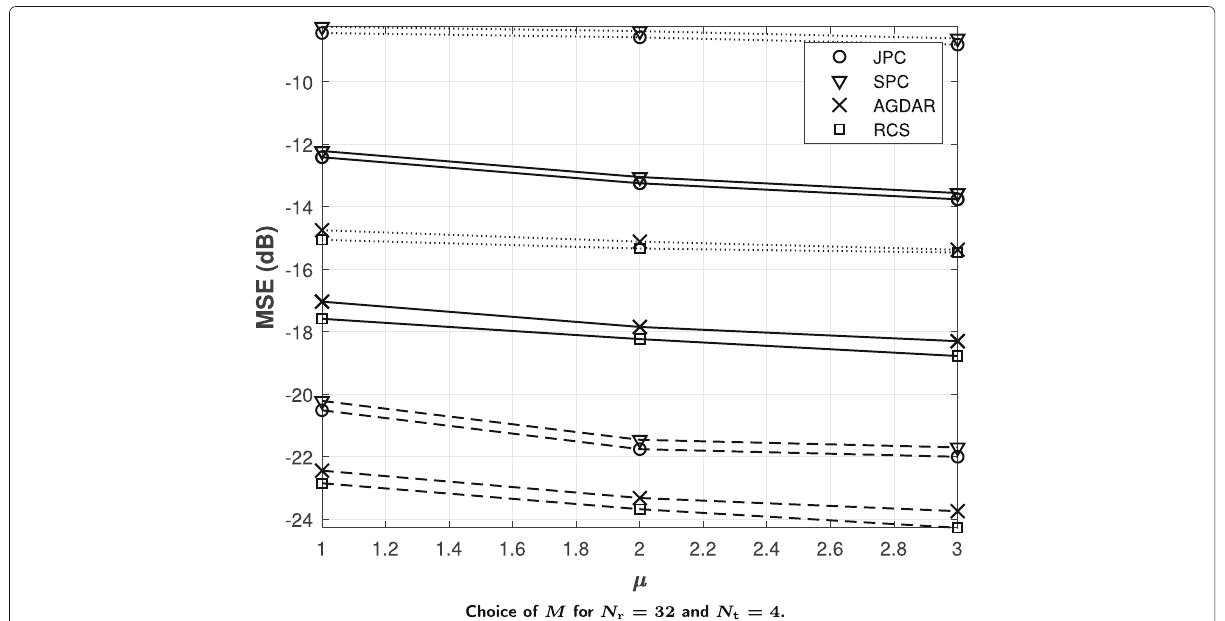
Fig. 7 Choice of M for N r = 32 and N t = 4. MSE vs μ for UPA with N r = 36 and N t = 4 at an SNR of 0 (dotted lines), 10 (solid lines) and 20 dB (dashed lines) and M 1 = μ N r and M 2 = μ N t . UMa LOS model